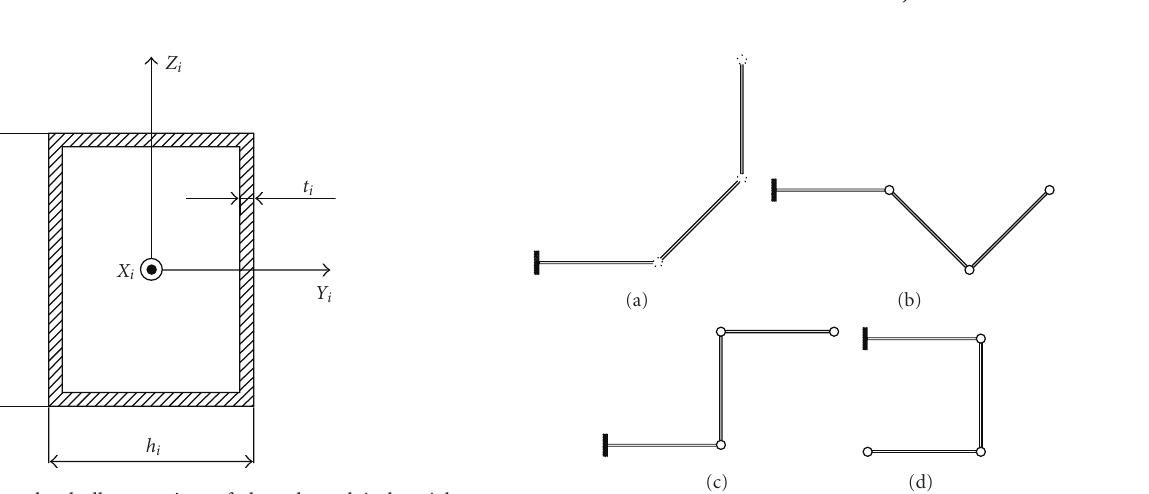
Figure 3: Rectangular hollow section of the adopted industrial manipulator. Figure 4: Test scenarios: (a) θ 2,3 = 45 ◦ , 45 ◦ ; (b) θ 2,3 = − 45 ◦ , 90 ◦ ; (c) θ 2,3 = 90 ◦ , − 90 ◦ ; (d) θ 2,3 = − 90 ◦ , − 90 ◦